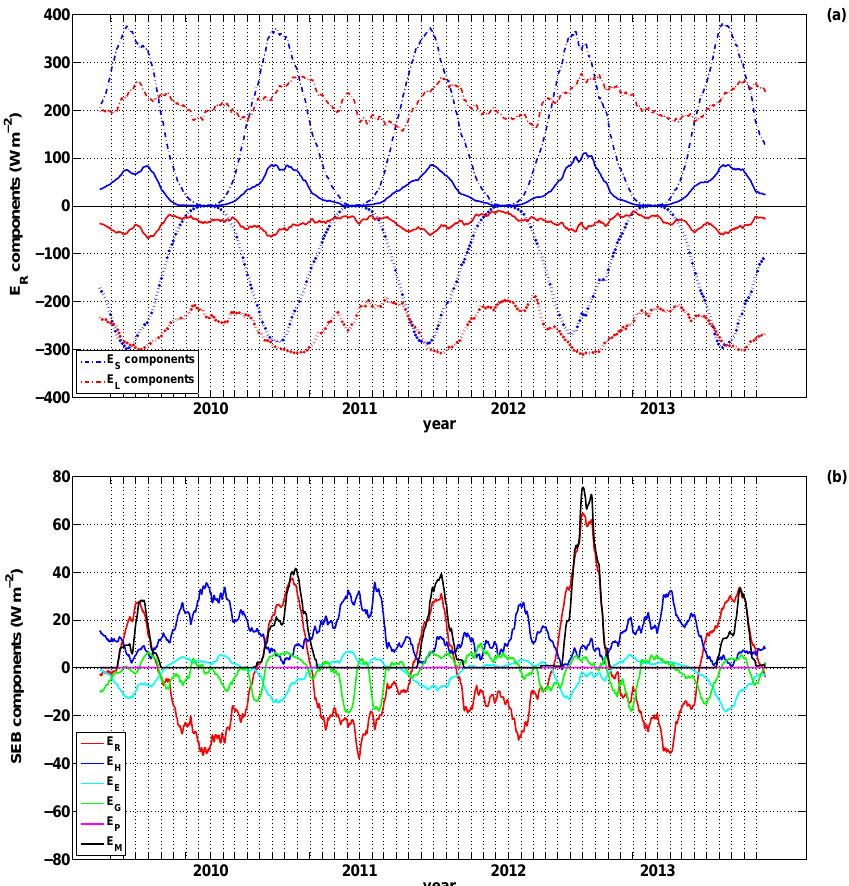
Figure 4. (a) Running average values for 31 days of all radiation budget components at KAN_U. Solid lines indicate the net solar and terrestrial radiation components. (b) Same as (a) but for all surface energy balance